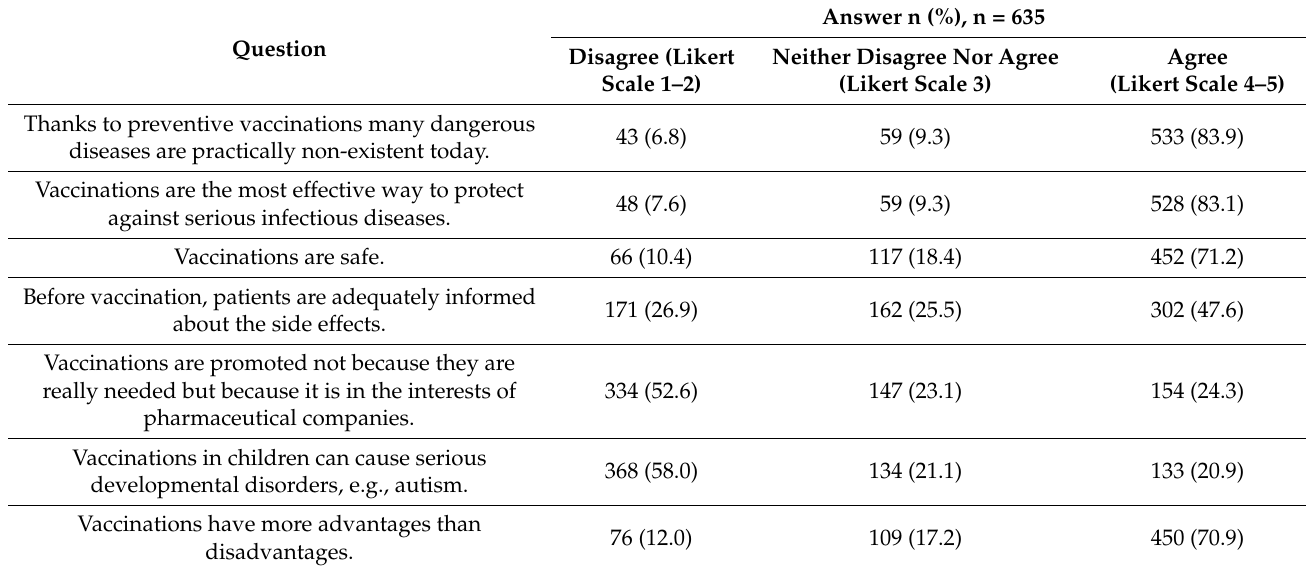
Table 2. Cancer patients’ general opinions on